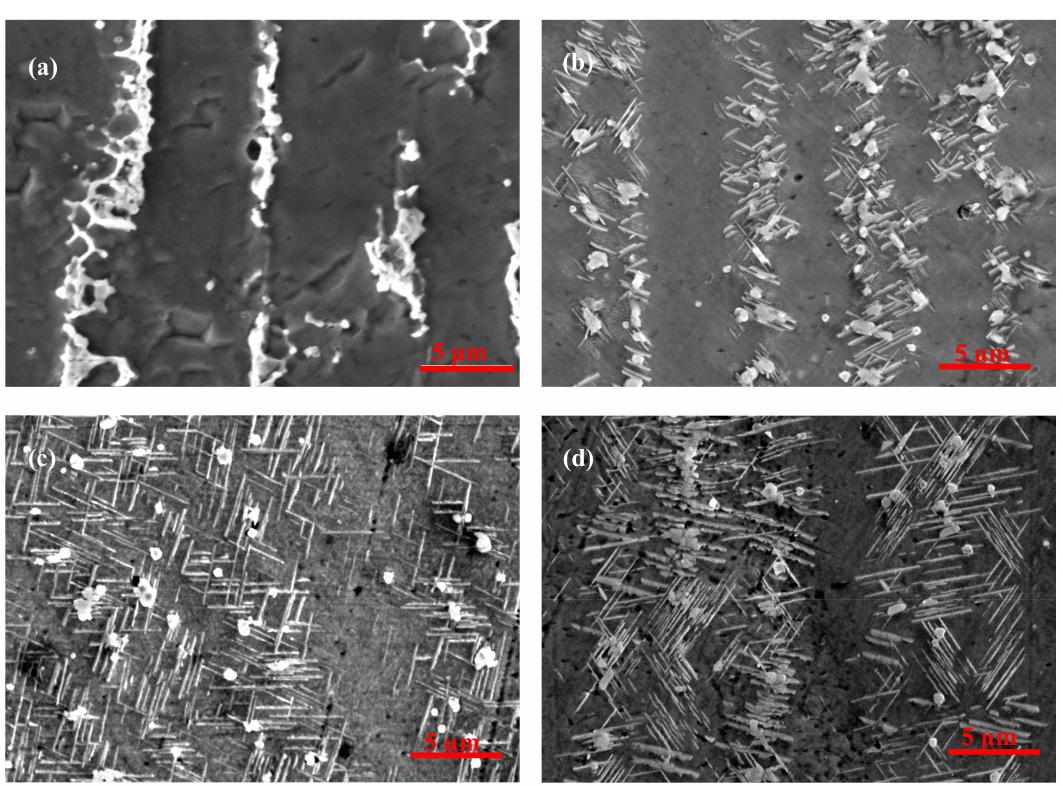
Figure 6. Morphology and distribution of the δ phase after aging at 950 ◦ C for di ff erent aging times for samples fabricated with electromagnetic stirring at 30 mT. ( a ) The as-deposited sample with 30 mT, ( b ) aging for 1 h, ( c ) aging for 4 h, and ( d ) aging for 16